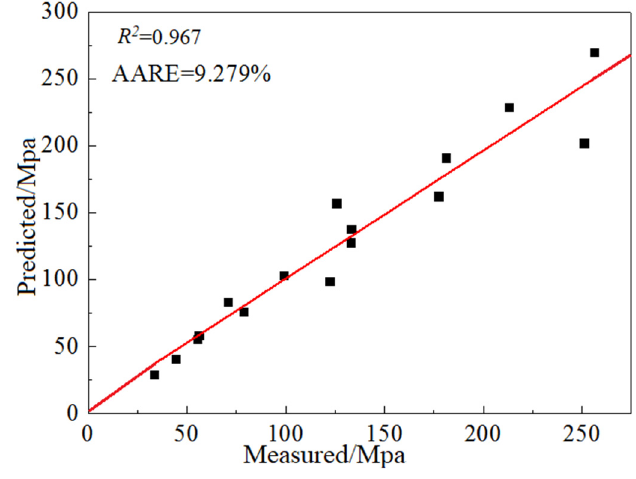
Figure 9. Measured versus the predicted ε 0.3 .